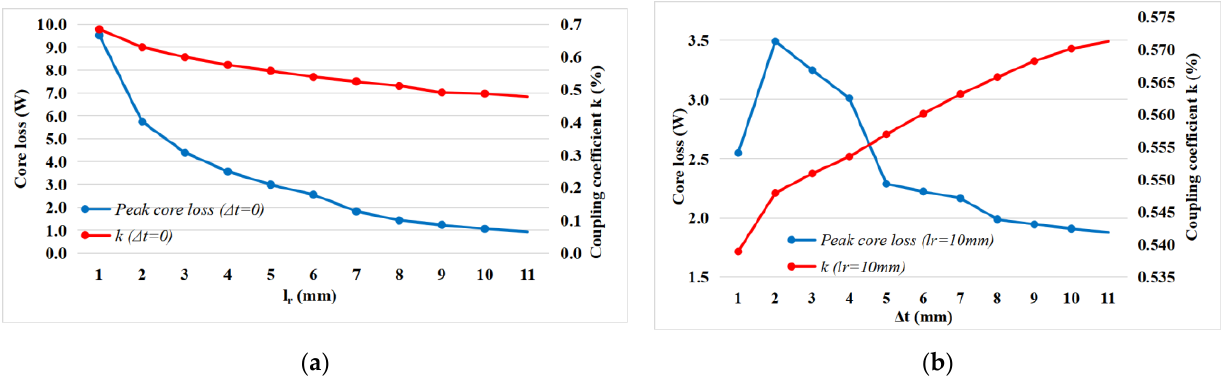
Figure 10. Simulation results of core loss and coupling coefficient: ( a ) Different removed ferrite length; ( b ) Increasing thickness.